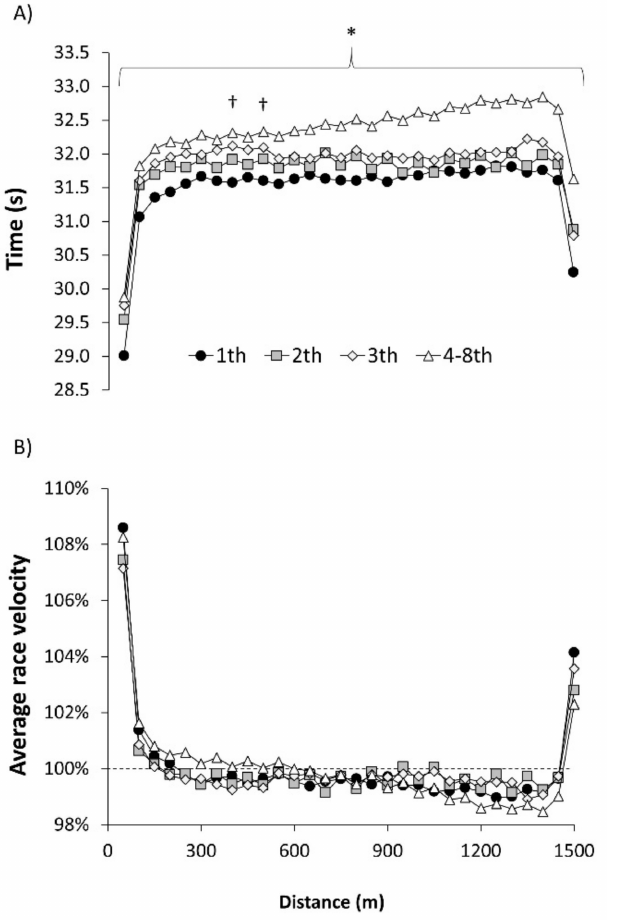
Figure 2. ( A ) Lap times for women swimmers for the 1500 m freestyle races of the World Champi- onships between 2003 and 2019 according to their final position in the race; ( B ) Race velocity in each lap with respect to the average race velocity. (*) Statistically significant difference between 1st and 4–8th positions at p < 0.05. (†) Statistically significant difference between 1st and 3rd positions at p < 0.05. Error bars have been removed for